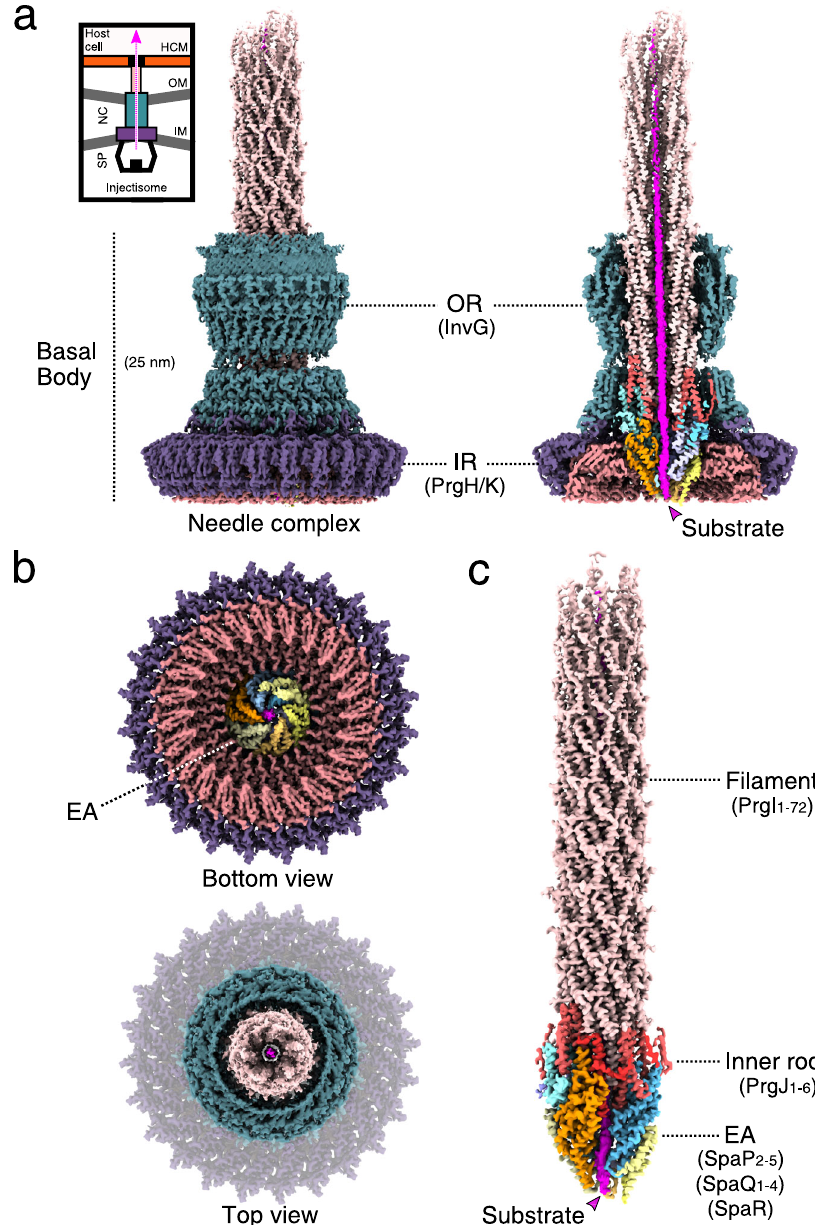
Fig. 1 Cryo-EM map of the S. enterica sv. Typhimurium needle complex engaged with the effector protein substrate SptP3x-GFP. a The non- symmetrized cryo-EM (C1) reconstruction of the substrate-engaged needle complex (left) with a vertical cross section through the center (right) revealing the substrate shown in magenta throughout the translocation channel. Upper left, is a cartoon schematic of the needle complex injectisome in the bacterial inner and outer membranes (IM/OM) and in contact with a host cell membrane (HCM). NC: needle complex, SP: sorting platform, OR: outer rings, IR: inner rings. The following colors are used in this and all other fi gures: PrgH 1-24 : dark violet (hex color #6d58ab), PrgK 1-24 : soft red (#dc888d), InvG 1-15/16 : dark cyan (#5f919c), SpaQs: yellow colors (SpaQ 1 #FFFF99, SpaQ 2 #FFFF66, SpaQ 3 #FFCC66, SpaQ 4 #CCCC99), SpaPs: blue colors (SpaP 1 #99CCFF, 1-72 : pale pink (#FFCCCC) and the substrate: magenta (#FF00FF). b Top and bottom views of the C1 map showing the export apparatus (EA) and substrate. c Cryo-EM map of the fi lament, inner rod, and the export apparatus components. SpaP 1 has been removed to aid visualization of the substrate.